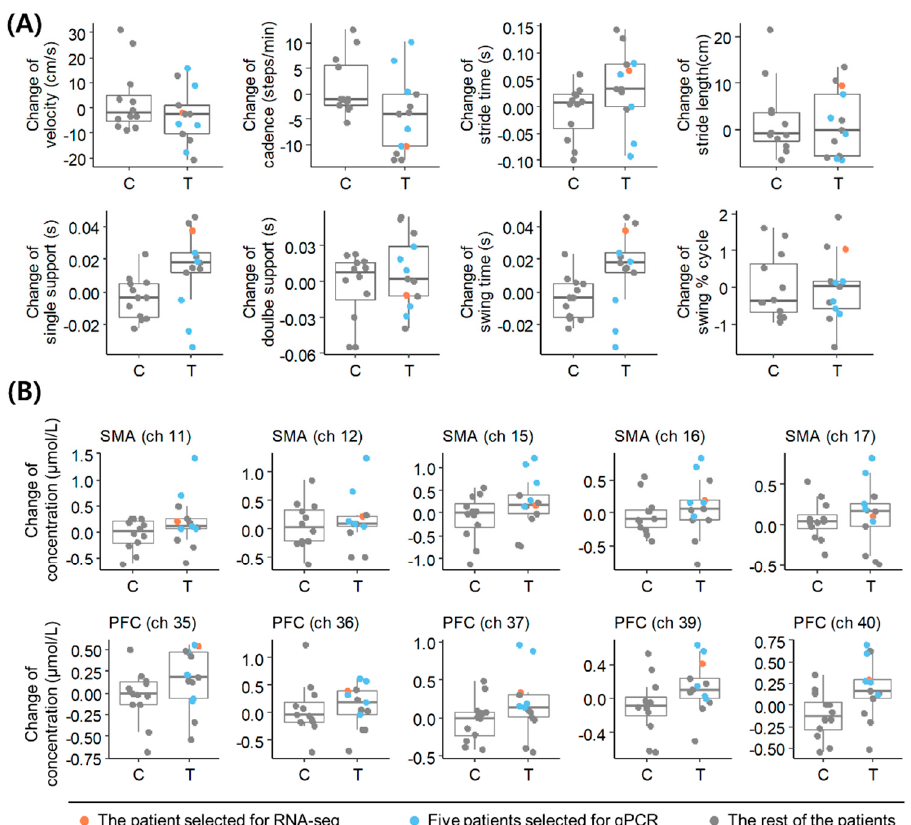
Figure 1. Clinical information for patients with PD. ( A ) Changes in gait parameters in the acupuncture treatment group (T) and control group (C) at V8 compared to V1. ( B ) Changes in oxyhemoglobin level in fNIRS channels in T and C at V8 compared to V1. Data of the representative patient selected for RNA − seq analysis and the other five patients selected for qPCR validation are highlighted with the indicated colors. SMA, supplementary motor cortex; PFC, dorsolateral prefrontal cortex; qPCR, quantitative real-time polymerase chain reaction; PD, Parkinson’s disease.